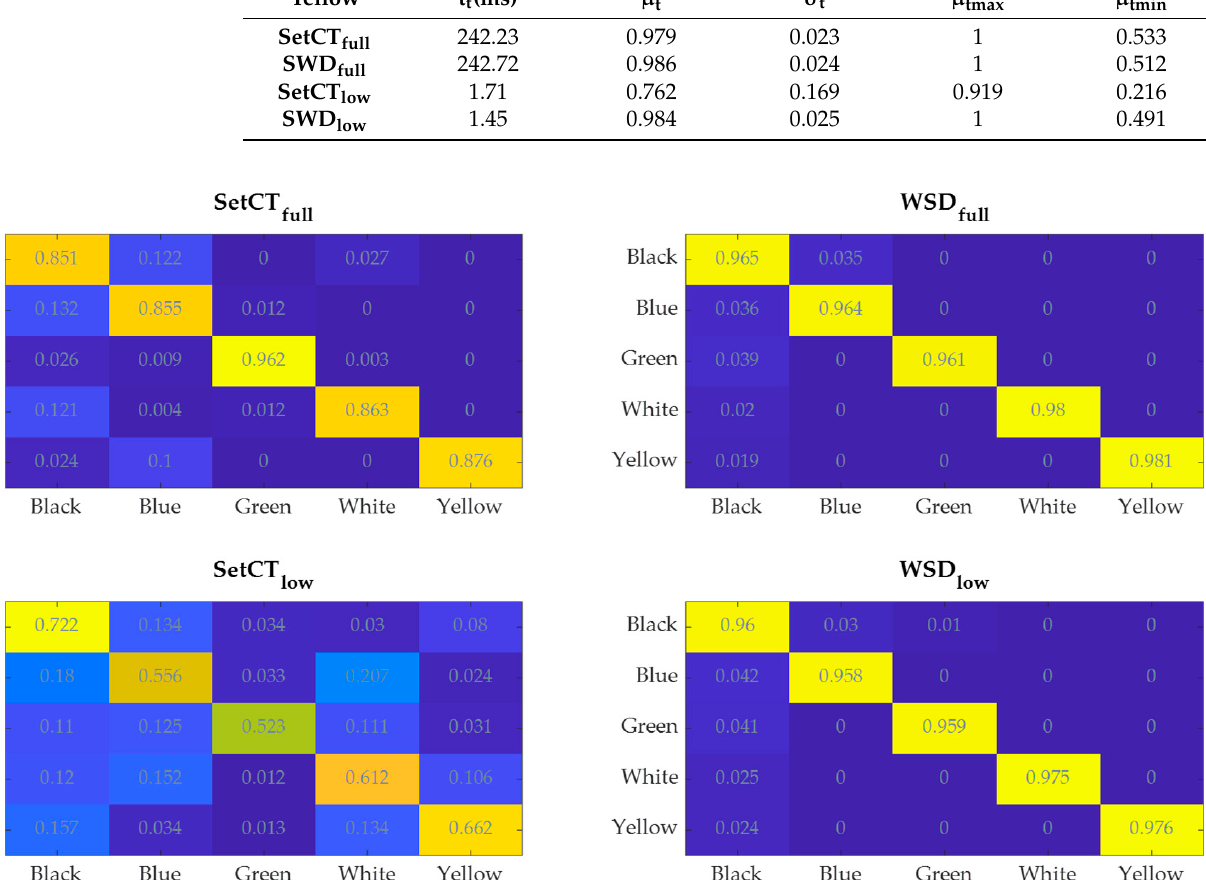
Table 6. Performance evaluation of the THz-FDS classification of a yellow sample.